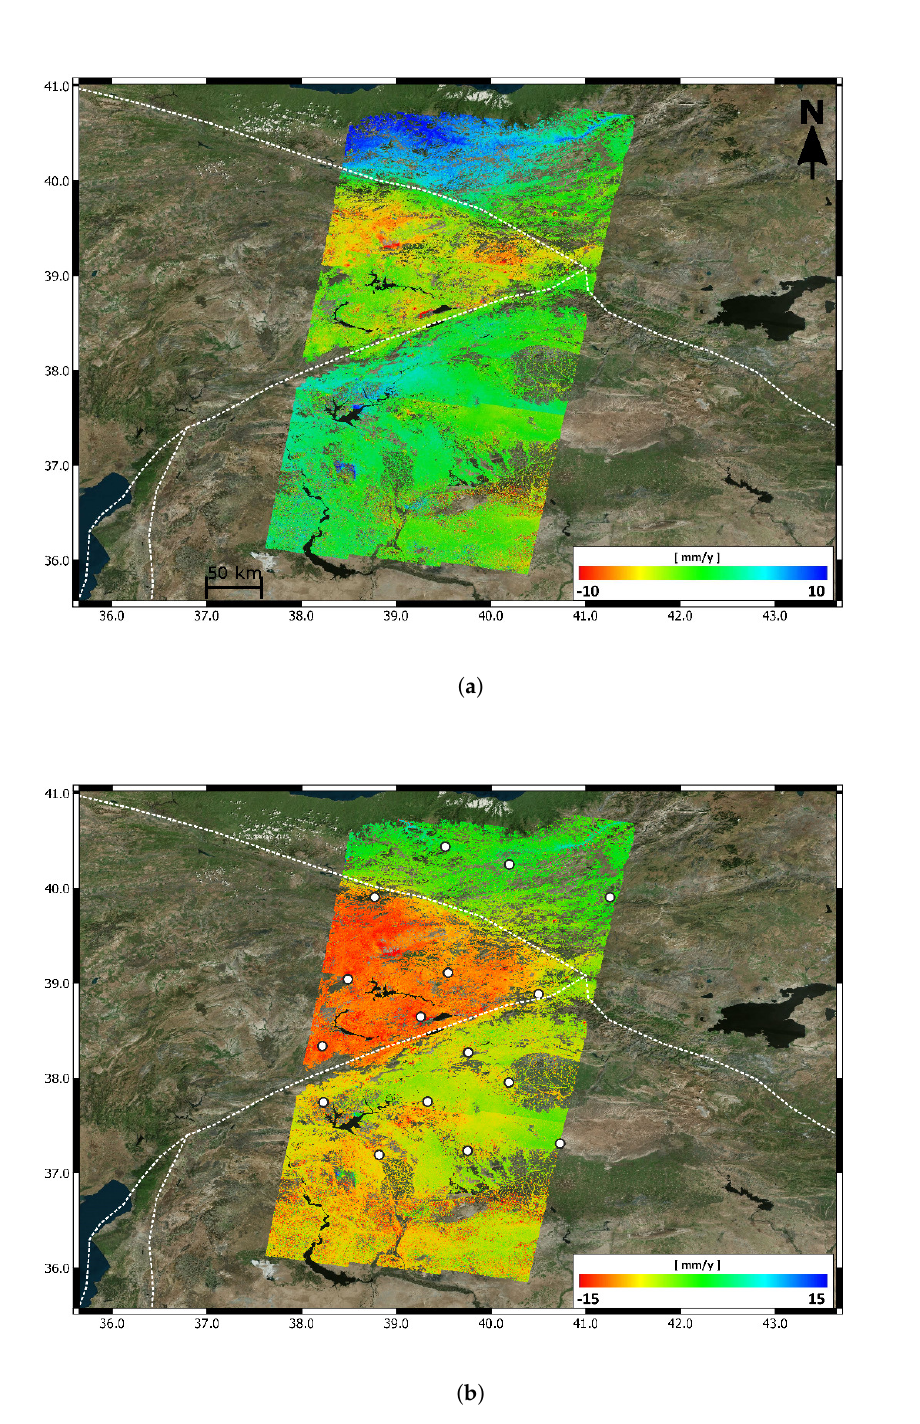
Figure 10. Results for the North Anatolian Fault ( a ) before and ( b ) after performing merging with GNSS data. In ( b ), the GNSS stations used are displayed with black–white circles and the fault lines are displayed using a white dashed